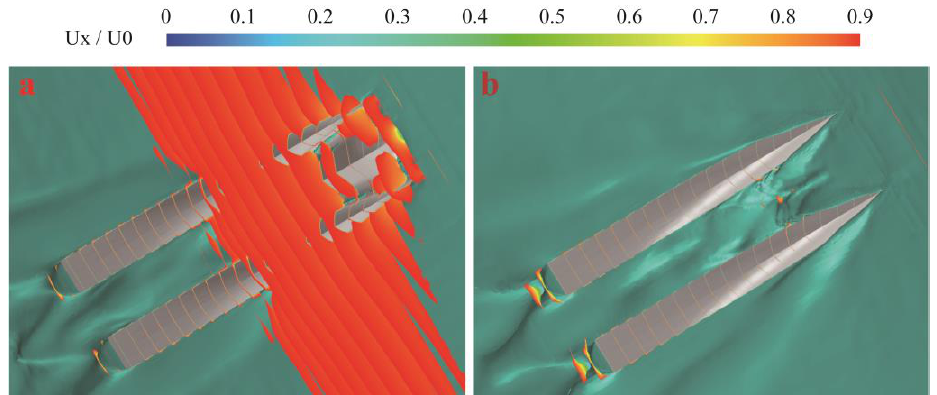
Figure 28. Free surface waveform and USV three-dimensional attitude at 5 level sea state (( left ): 0 ◦ wave direction; ( right ): 30 ◦ wave direction).